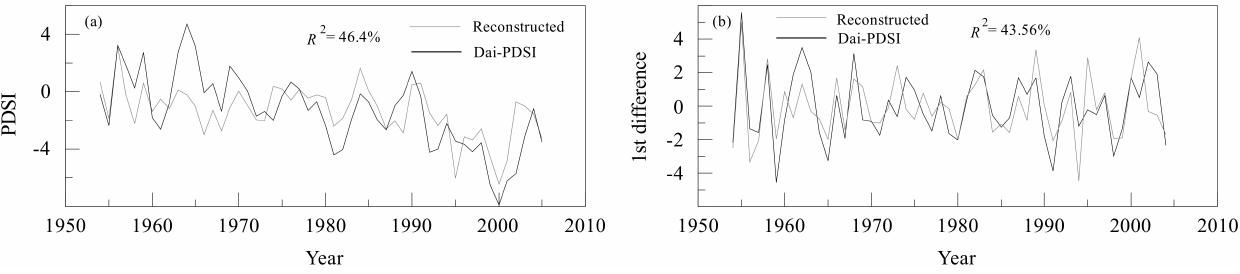
Fig. 5. Comparisons (a) between reconstructed PDSI and Dai-PDSI, and (b) between the first differences of reconstructed and Dai-PDSI over their common period of